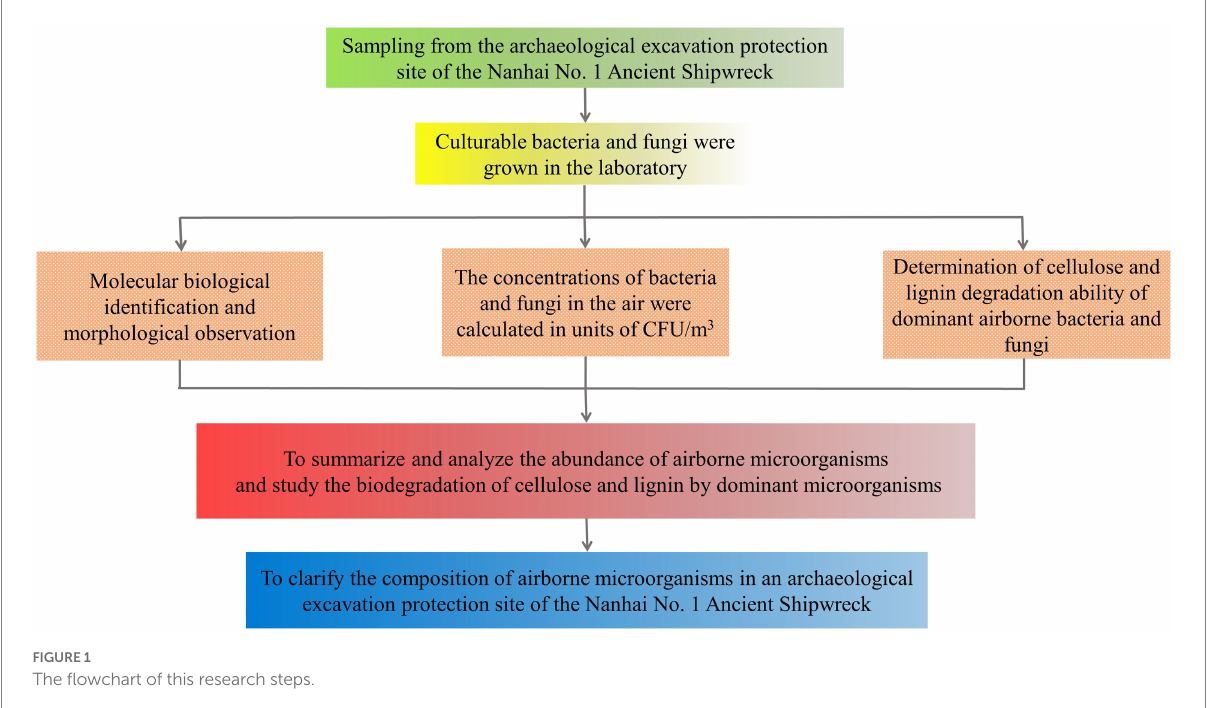
FIGURE 1 The flowchart of this research